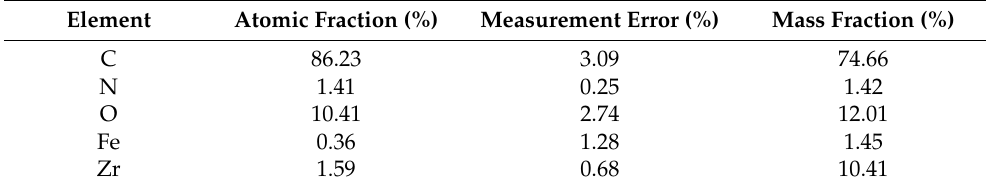
Figure 1. The specific surface area of MOF-525 and MOF-525-Fe/Zr can be calculated Table 1. Analysis of element composition spectrum (EDX) of single MOF-525-Fe/Zr crystal cell. Element Atomic Fraction (%) Measurement Error (%)